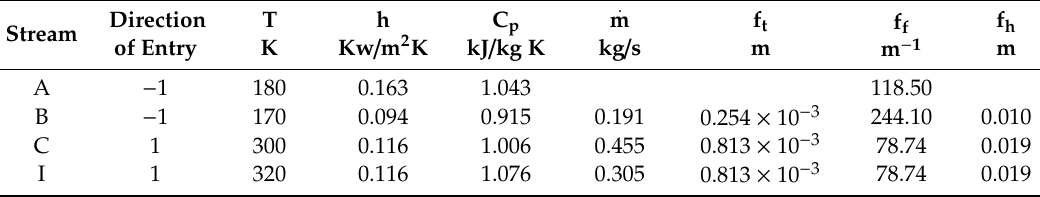
Table 4. Determinate variables of the heat